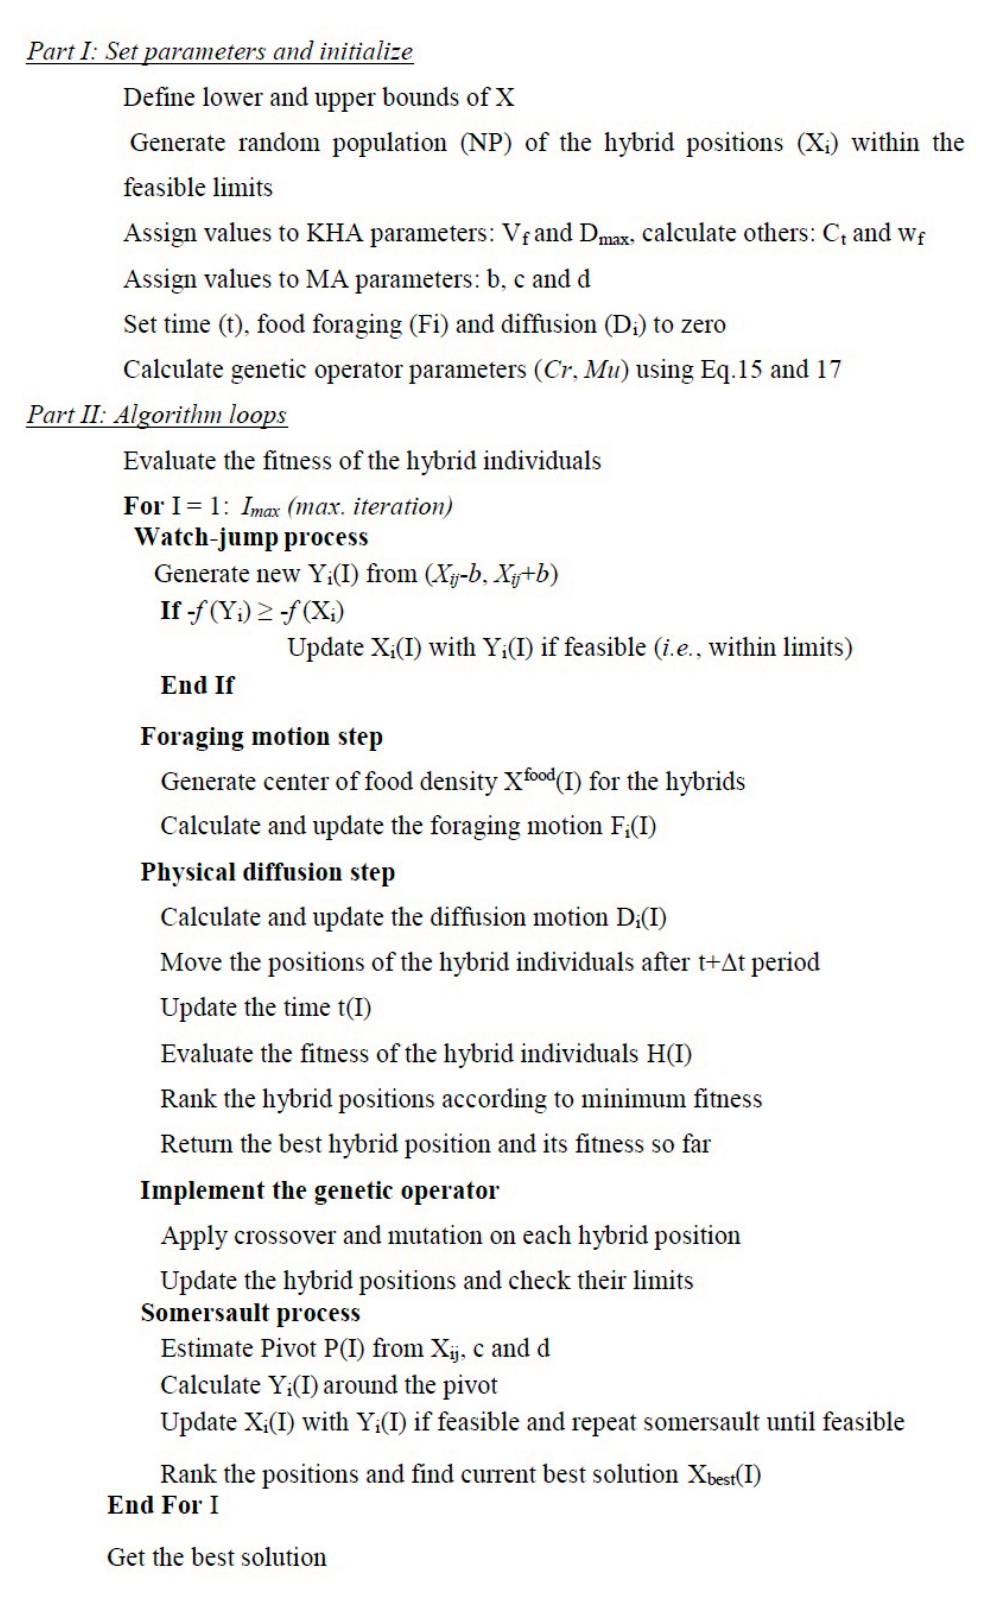
Figure 3. The pseudo-code of hybrid